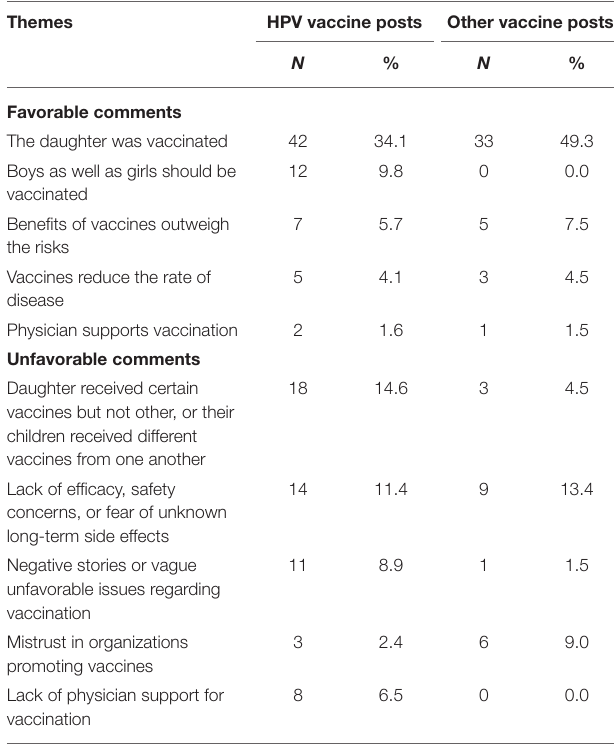
TABLE 1 | Themes in the comments to posts on human papillomavirus (HPV) and other